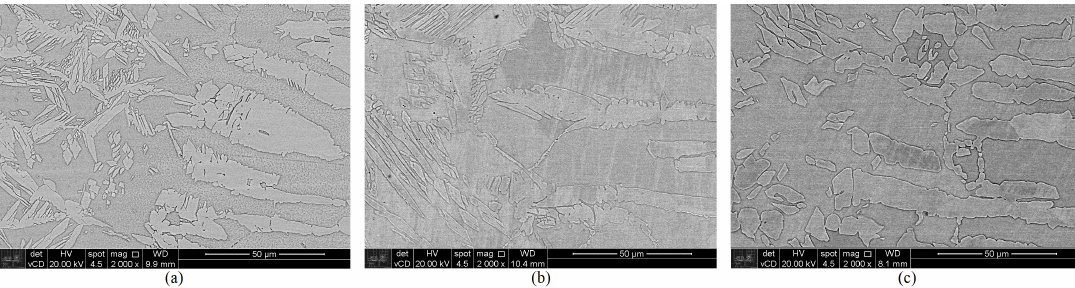
Figure 10. Duplex microstructure of the boundary zone welded with the following welding energies: (a) 0.5 kJ.mm -1 , (b) 1.0 kJ.mm -1 e (c) 3.5 kJ.mm -1 . The matrix is the ferrite phase, and the precipitates are the austenite phase. The microstructures show the differences in the austenite morphology. The lower welding energy presented a steep morphological gradient and acicular austenite (sawtooth). In comparison, welding with higher energies showed a smother morphological gradient, with coarser austenite precipitation. There is no indication of the sigma phase precipitates (BEI resolution is around 500 nm). SEM, BEI, electrolytic etching in oxalic acid solution.